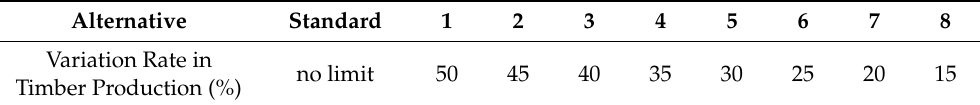
Table 6. Management alternatives with differing timber production variation